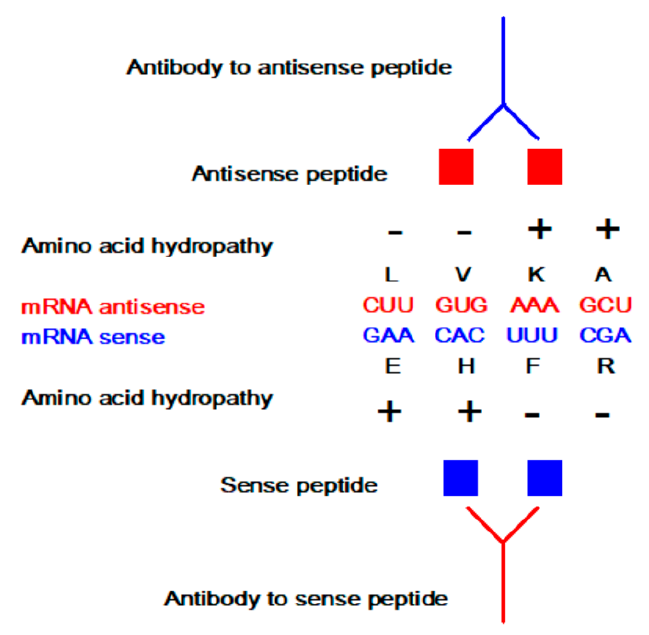
Figure 1. Modeling of sense-antisense peptide binding and related epitope-paratope interactions. Sense peptides are essential and specific parts of viral and other proteins that elicit